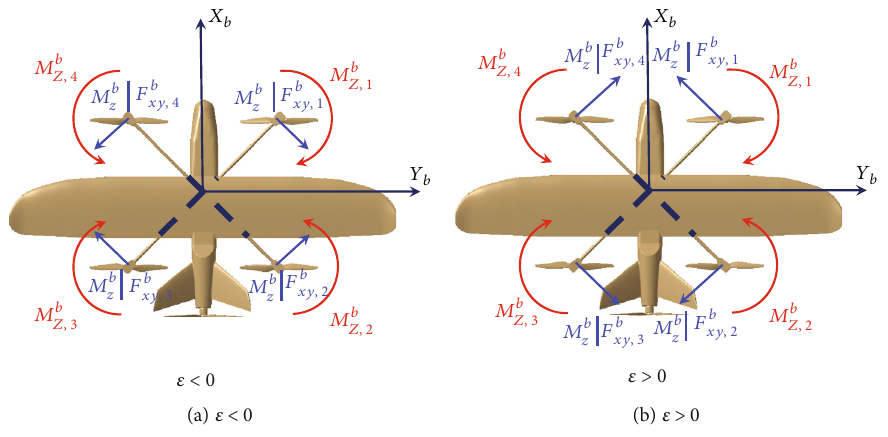
Figure 40: Extra moment (in blue) due to rotor